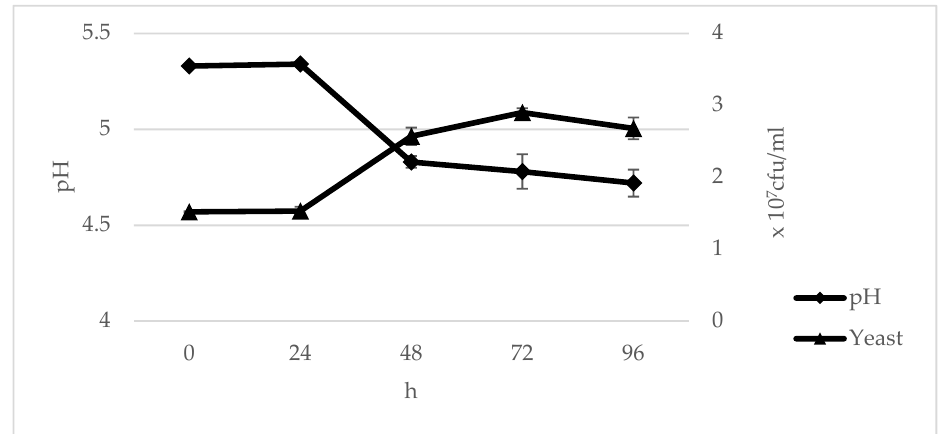
Figure 3. Pichia norvegensis NYI growth and changes in the pH of tofu wastewater as growth media.